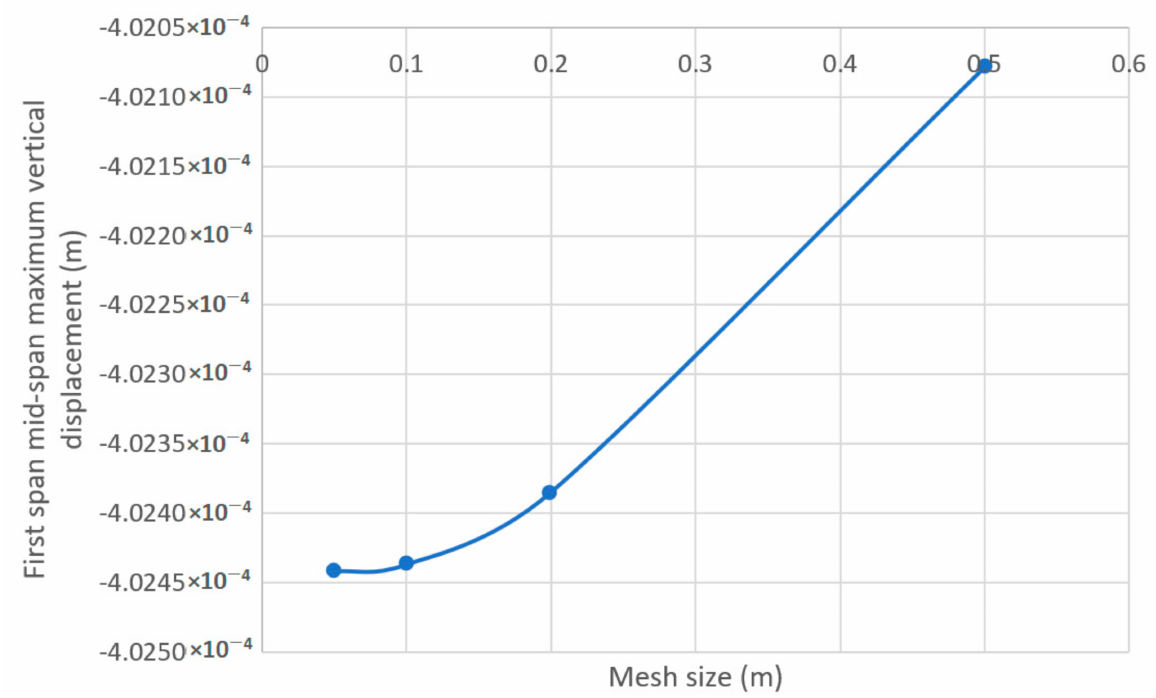
Figure 13. Mesh sensitivity plot for the three-span